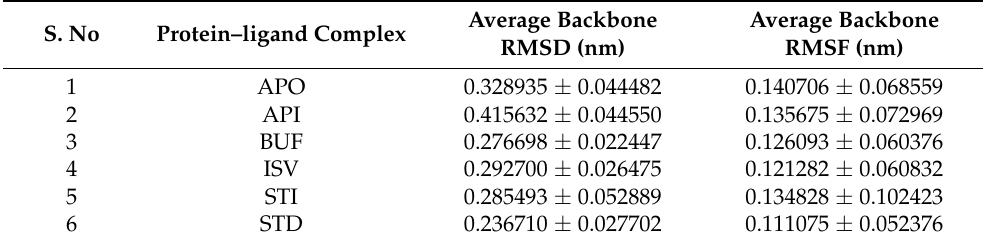
Table 5. Molecular dynamics simulation for the selected top binding scored bioactive molecules. Average S. No Protein–ligand Complex